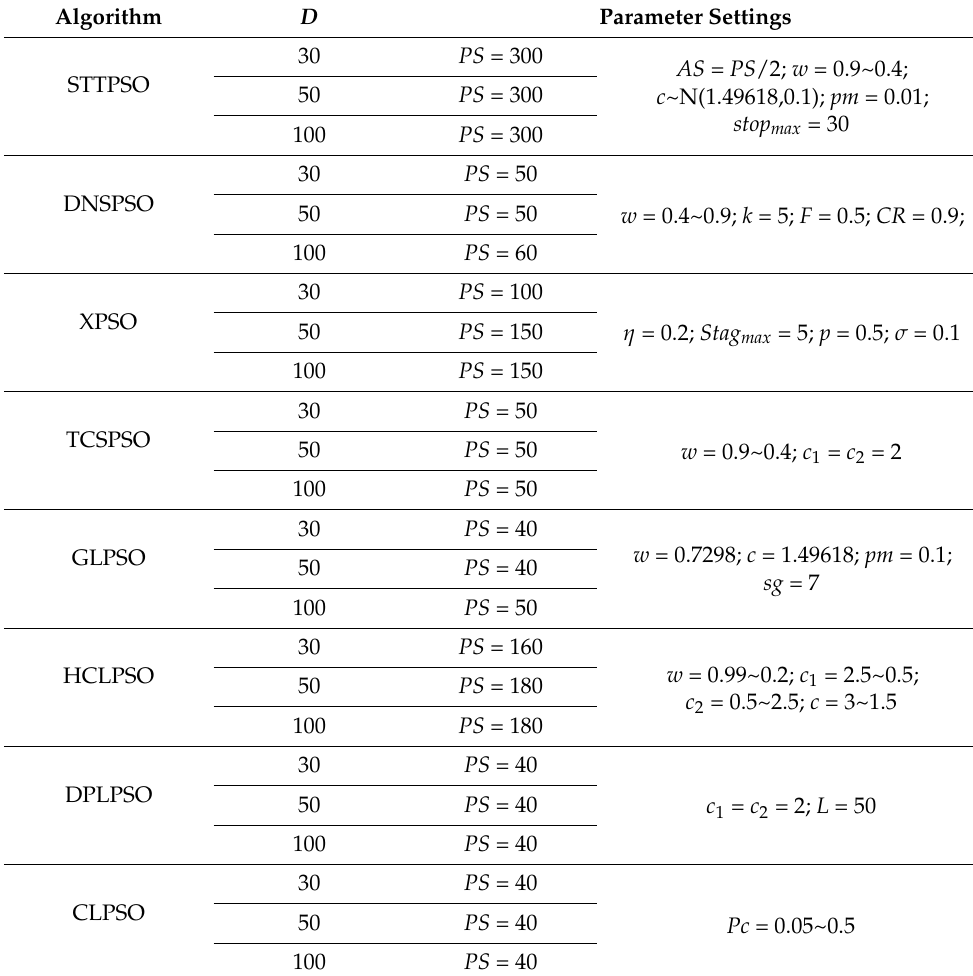
Table 2. Parameter settings of the proposed STTPSO and the compared algorithms.